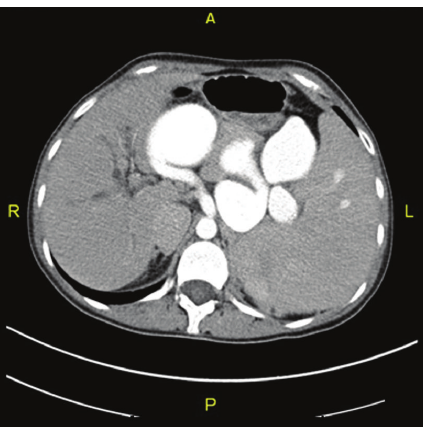
Figure 1: Computerized Tomography (CT) scan shows multiple aneurysms along splenic artery.